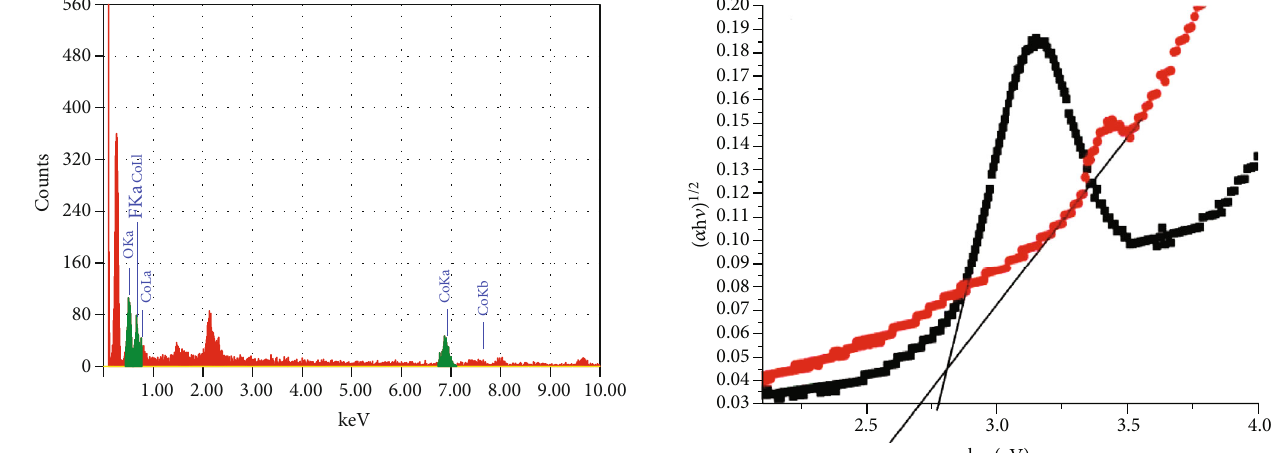
NPs. 2 Figure 6: Band gap calculation of CoF drying.